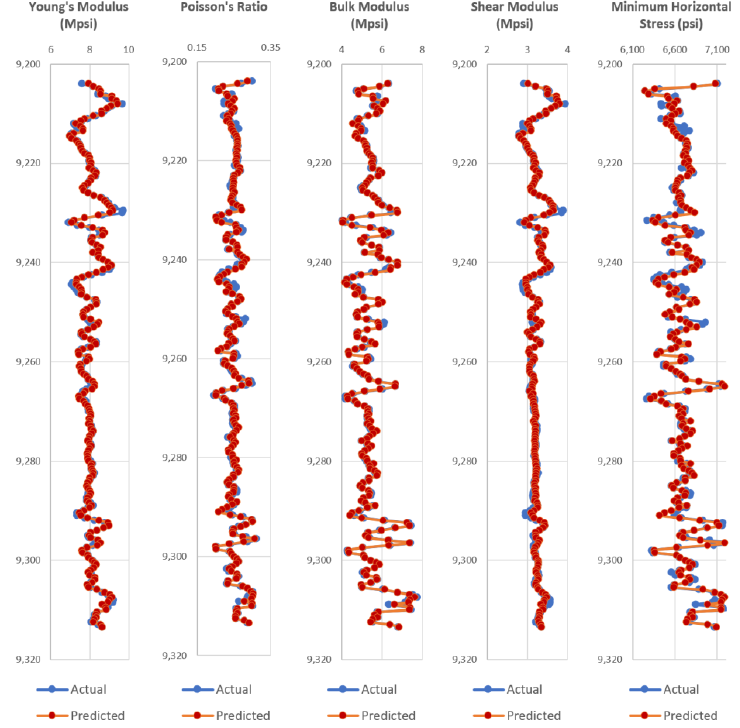
Figure A2. Actual and predicted geomechanical properties along with depth (feet) for test well 1 in Burke County for the Middle Bakken Formation.